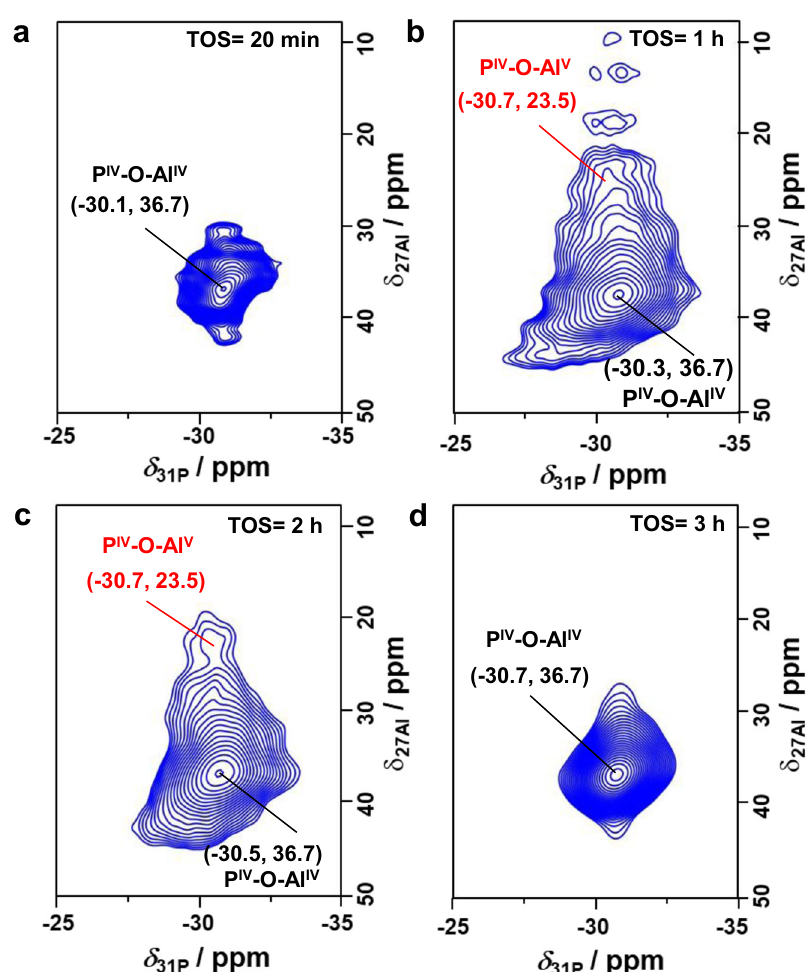
Fig. 2 Discrimination of 31 P- 27 Al correlations by 2D 31 P- 27 Al HETCOR MAS NMR experiments. a – d 2D 31 P- 27 Al HETCOR MAS NMR spectra of the spent SAPO-34 catalysts after MTO conversion at 623 K for different TOS of 20 min to 3